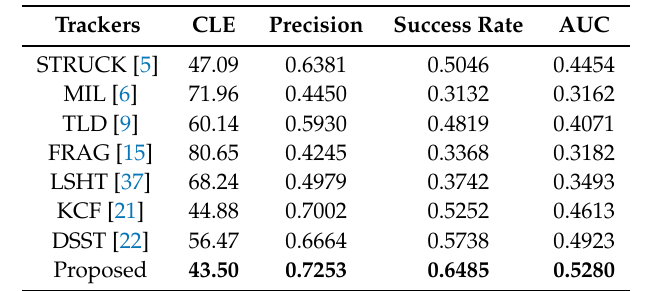
Table 1. The average performance evaluation results of trackers with the proposed method for 100 sequences in the OTB-100 database. The bold values mean the best performance. CLE, center location